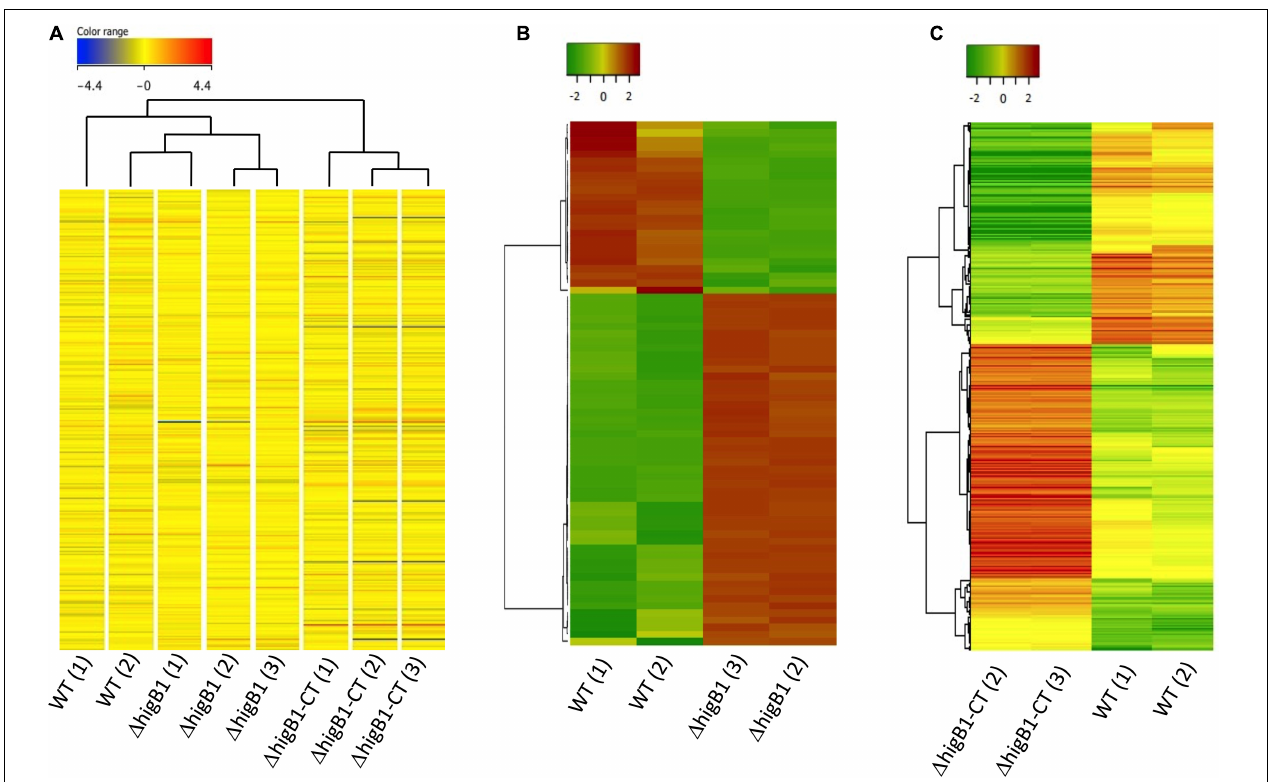
FIGURE 7 | Global transcriptome profile of H37Rv, (cid:49) higB 1 mutant and complemented strains through microarray analysis. (A) The hierarchical cluster analysis, representing the gene expression profile of all genes in sample replicates. Expression values are color coded based upon the extent of expression where red color indicates high level of expression and blue color indicates low level of expression. (B,C) The Unsupervised hierarchical clustering of differentially expressed genes in (cid:49) higB1 mutant vs. wild type strain (B) or complemented strain vs. wild type (C) . Expression values are color coded based upon the extent of expression where red color indicates high level of expression and green color indicates low level of expression. The clustering was done using Pearson distance algorithm with average linkage